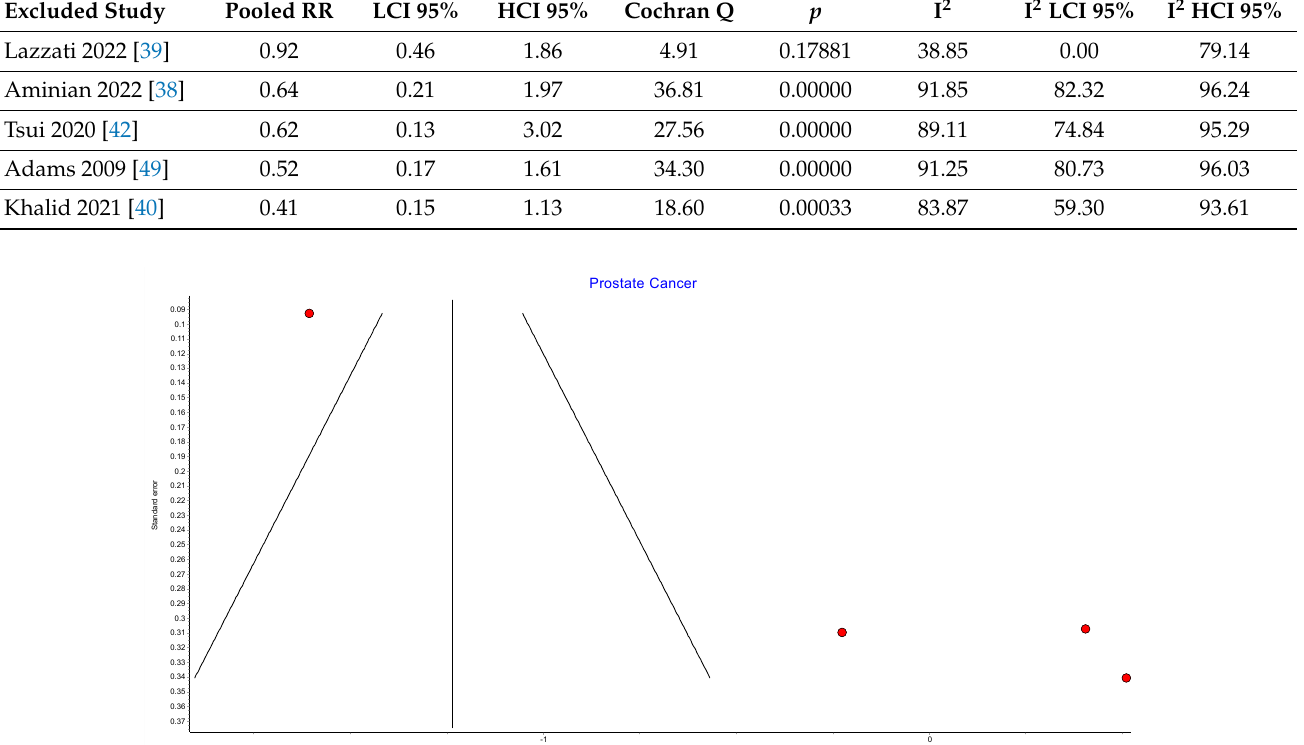
Table A19. Gastric cancer random effects model sensitivity analysis.